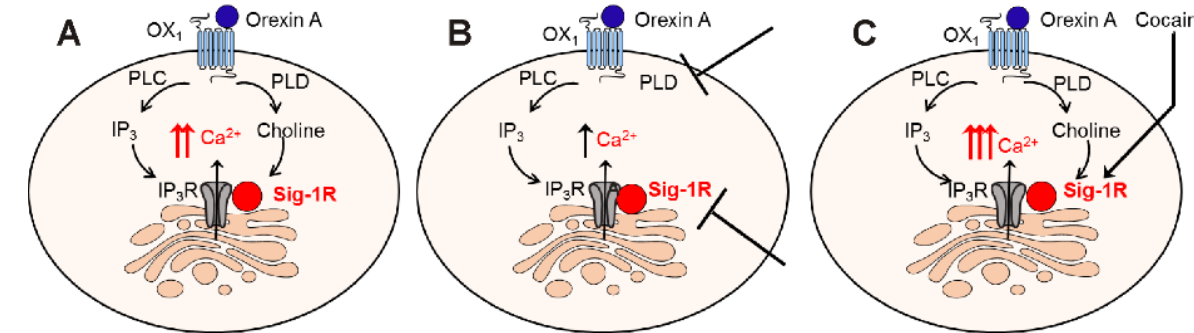
Figure 5. Diagram illustrating the proposed model of potentiation of orexin by cocaine via Sigma-1R in nucleus accumbens neurons. ( A ) Orexin A acting on OX 1 receptor activates PLC and PLD. PLC increases IP 3 level and promotes the Ca 2+ release from endoplasmic reticulum via IP 3 receptors (IP 3 R). PLD produces choline (from hydrolysis of phosphatidylcholine) that acts on Sigma-1R to potentiate Ca 2+ increase via IP 3 R (higher increase in [Ca 2+ ] i ). ( B ) Inhibition of PLD or antagonism of Sigma-1R limits the orexin A-OX 1 receptor signaling to PLC-mediated IP 3 -dependent increase in Ca 2+ (smaller increase in [Ca 2+ ] i ). ( C ) Cocaine, via Sigma-1R activation, potentiates the PLC- and PLD-mediated increase in [Ca 2+ ] i produced by orexin A acting on OX 1 (highest increase in [Ca 2+ ] i ). The diagram was created using the Motifolio Illustration Toolkit Neuroscience (https://www.motifolio.com accessed on 7 March 2021).